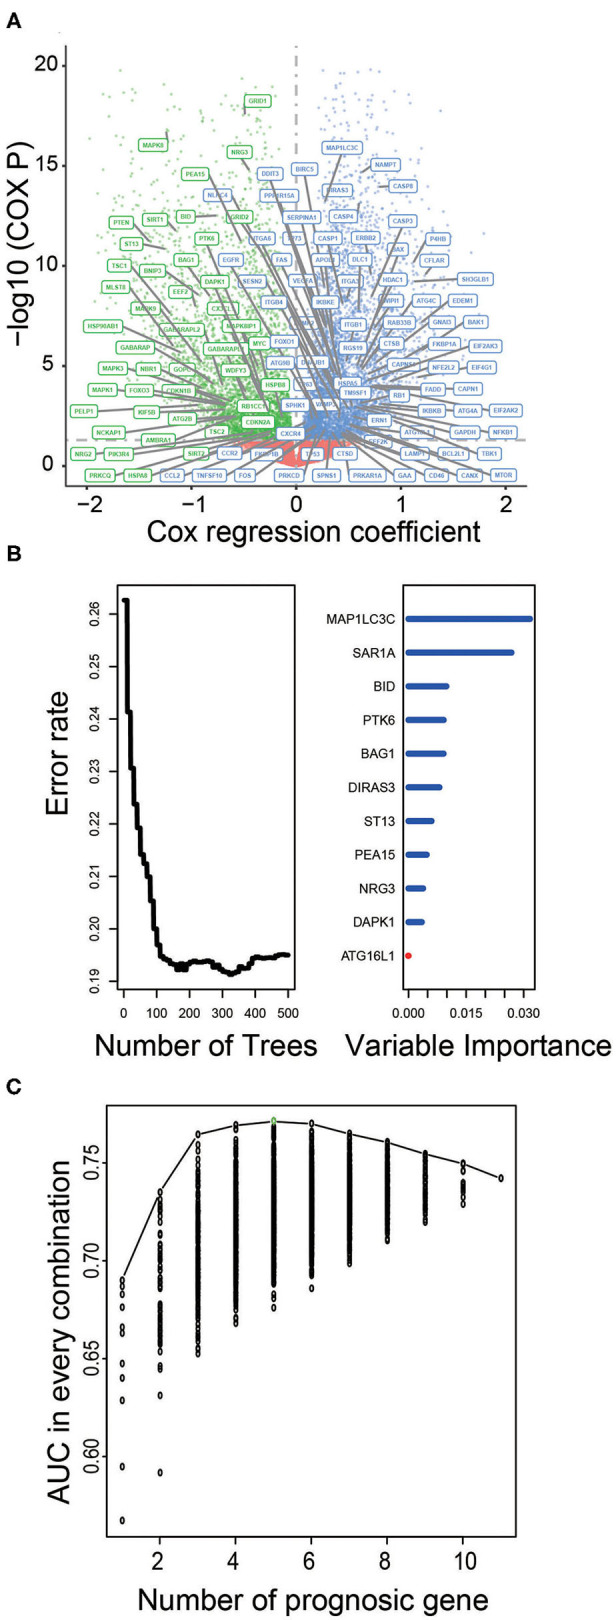
Identification of prognostic ATGs and constructing prognostic models in the training dataset. (A) Volcano plot showed the ATGs associated with LGG survival in the training set. (B) The prognostic ATGs were reduced to 11 by random forest supervised classification algorithm. (C) The prognostic five-ATG signature was selected for its largest AUC (AUC = 0.71).